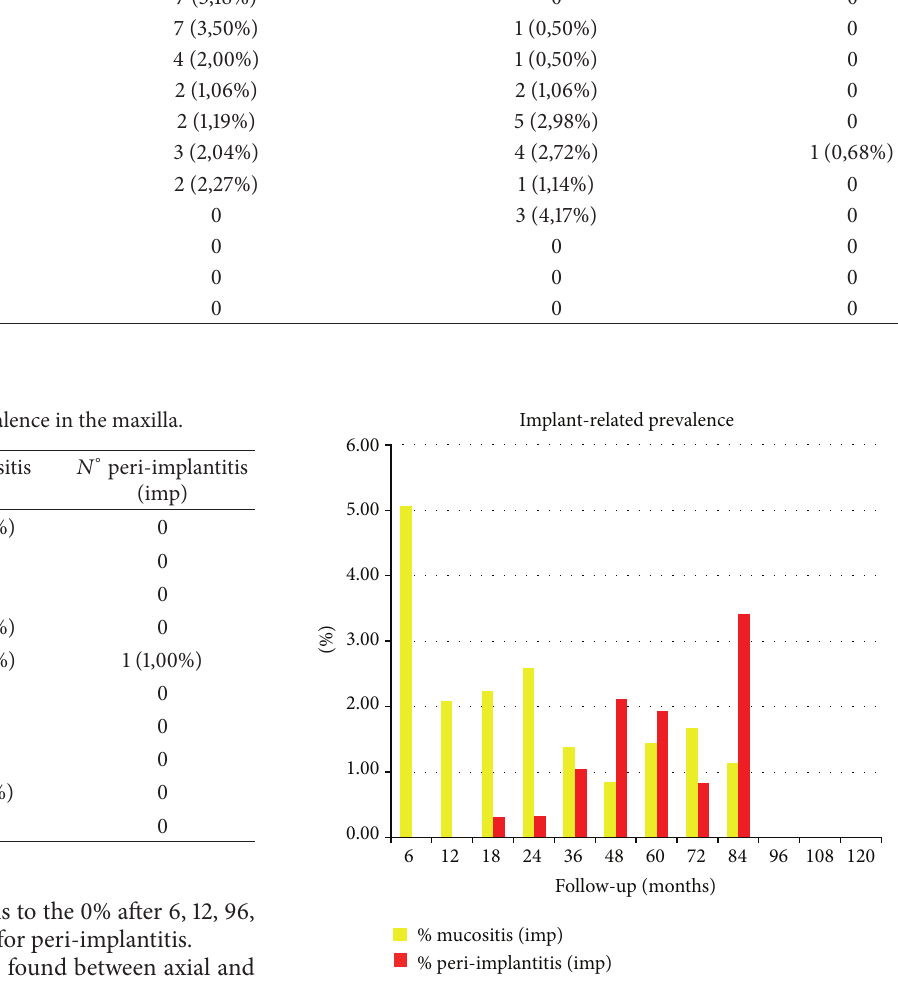
Figure 2: Overall implant-related prevalence of peri-implant muco- sitis and